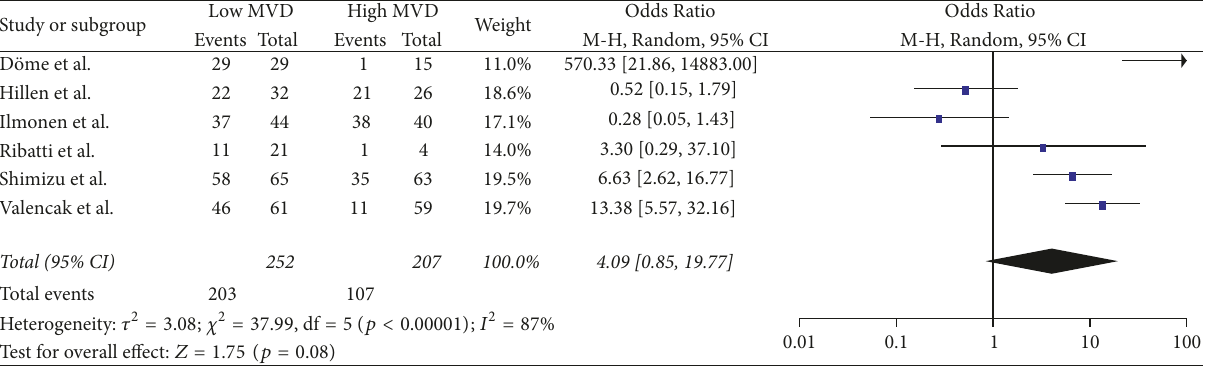
Figure 6: 60 months’ overall survival.